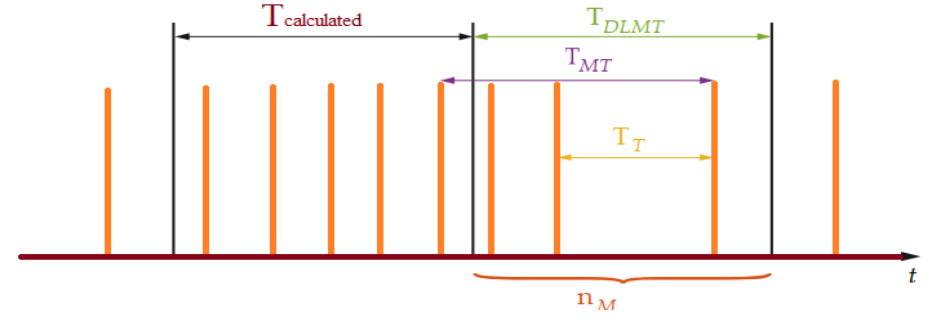
Figure 4. MT and DLMT algorithms of measurement [15] .